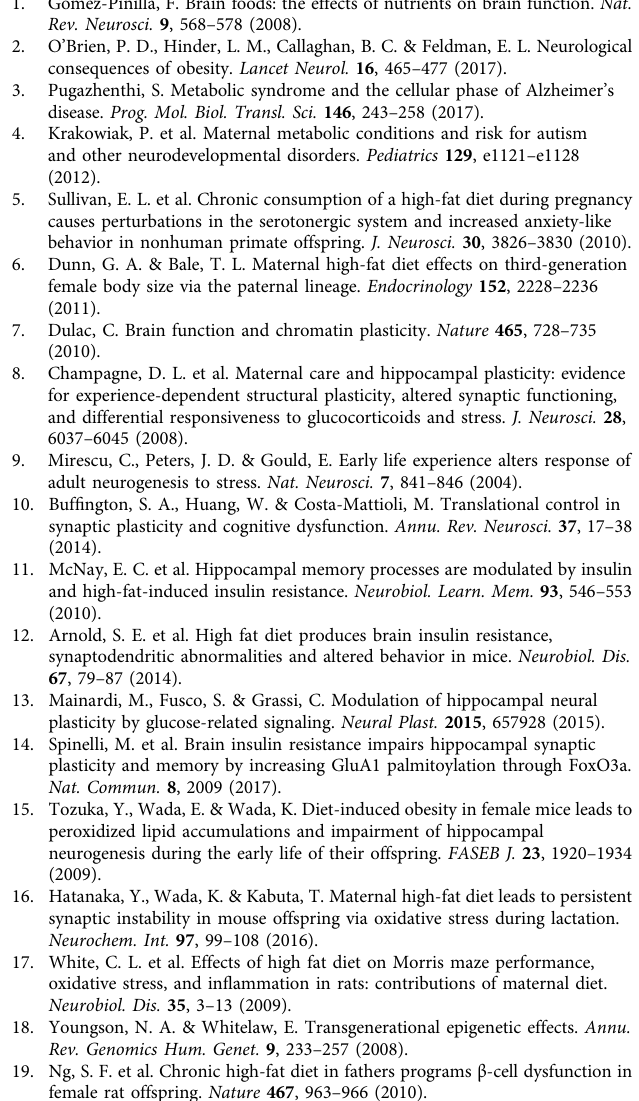
Supplementary Table 2. PCR conditions and cycle numbers were determined empirically and each PCR reaction was performed in triplicate. Data are expressed as the percentage of input calculated by the Adjusted input value method according to the manufacturer ’ s instructions (ThermoFisher Scienti fi c ChIP Analysis). To calculate the Adjusted input, the Ct value of input was subtracted by 6.644 (i.e., log2 of 100). Next, the percentage of input of samples was calculated using the formula: 100× 2^(Adjusted input − Ct(ChIP). The percentage of input of IgG samples was calculated using the formula 100 ×2^(Adjusted input −